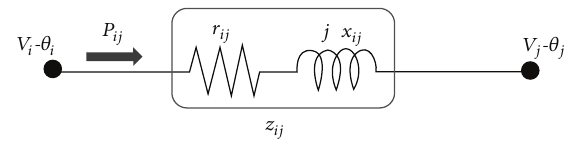
Figure 2: Transmission line